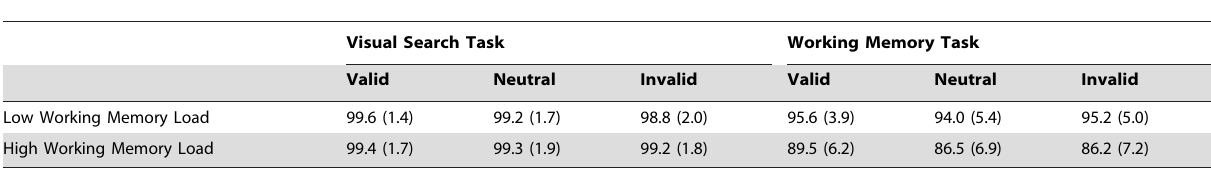
Table 1. Mean Percentages of Accuracy Rates (Standard Deviations in Parentheses) in Visual Search and Working Memory Tasks.